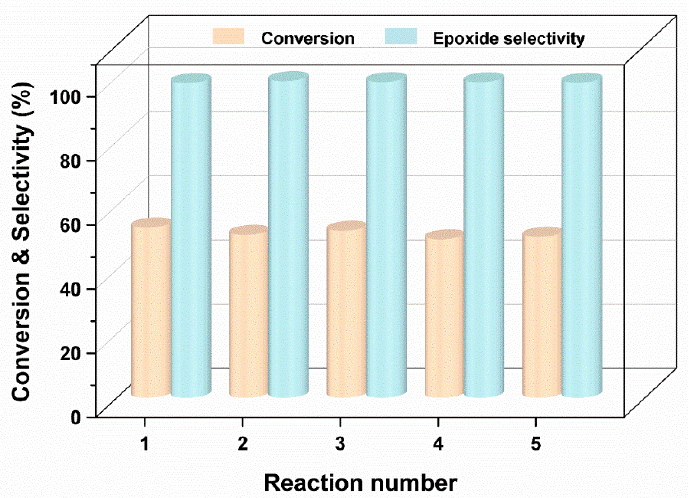
Figure 6. Recycling experiments of cyclopentene epoxidation catalyzed by TS-1_P-0.05K with H 2 O 2 as oxidant. Reaction conditions: catalyst 50 mg, cyclopentene 10 mmol, H 2 O 2 10 mmol, CH 3 OH 10 mL, and temperature 313 K.